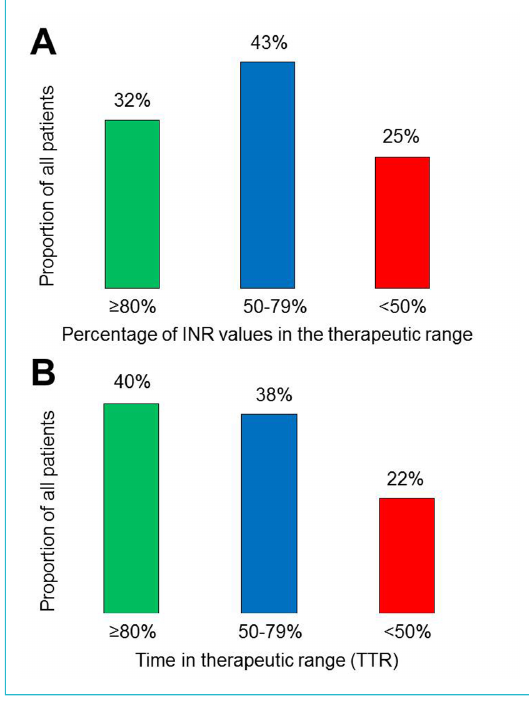
Figure 1: Bar graph showing the proportion of patients with high (≥80%), intermediate (50–79%), and low (<50%) percentage of percentage of international normalised ratio (INR) values in the therapeutic range (panel A) and high (≥80%), intermediate (50–79%) and low (<50%) time in therapeutic range (TTR, panel B).